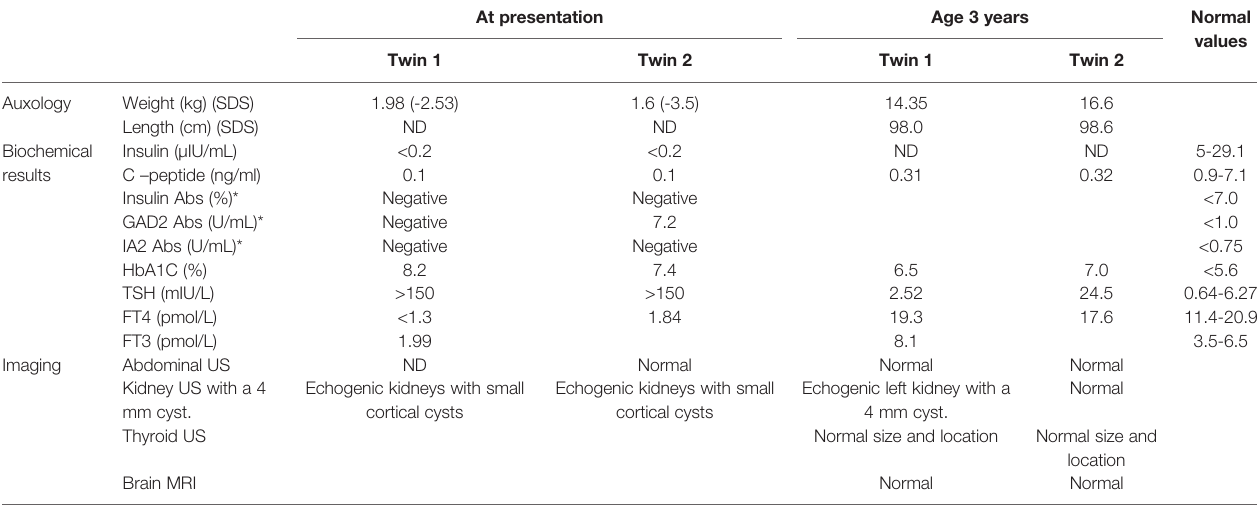
TABLE 1 | Auxologic, biochemical and imaging fi ndings in the twins.